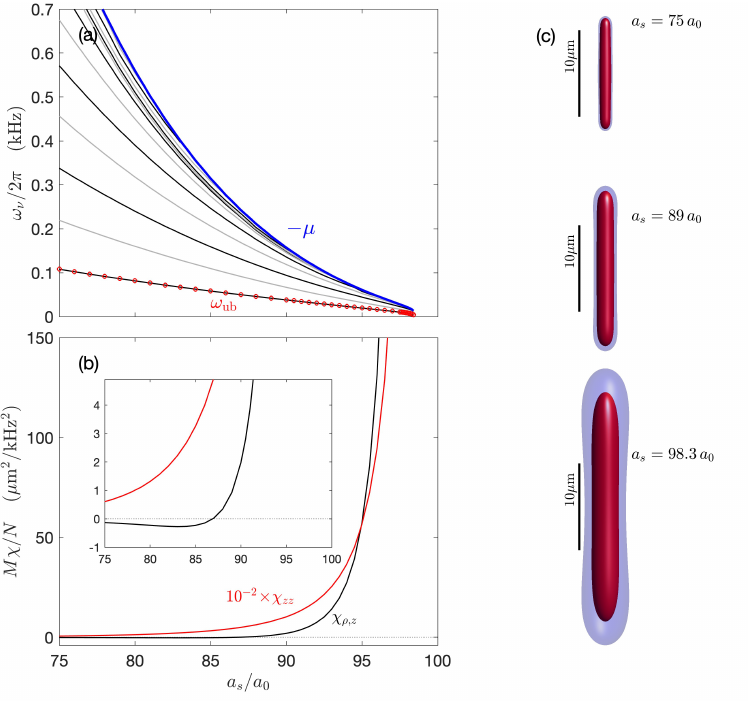
Figure 2. Free-space droplet ( V = 0) as a function of s-wave scattering length a s . ( a ) Results from numerical solution of the BdG equations for the m = 0 excitations that are even (black lines) and odd (grey lines). The approximate result ω ub obtained from (15) (red circles). The droplet binding energy, characterized by − µ , is shown for reference (blue line). ( b ) The static polarizabilities χ zz and χ ρ z . ( c ) Density isosurfaces of droplet states for various a s values as labelled. Isosurfaces shown for 10 18 m − 3 (blue) and 10 19 m − 3 (red). Results for N = 10 4 164 Dy atoms using a dd = 130.8 a 0